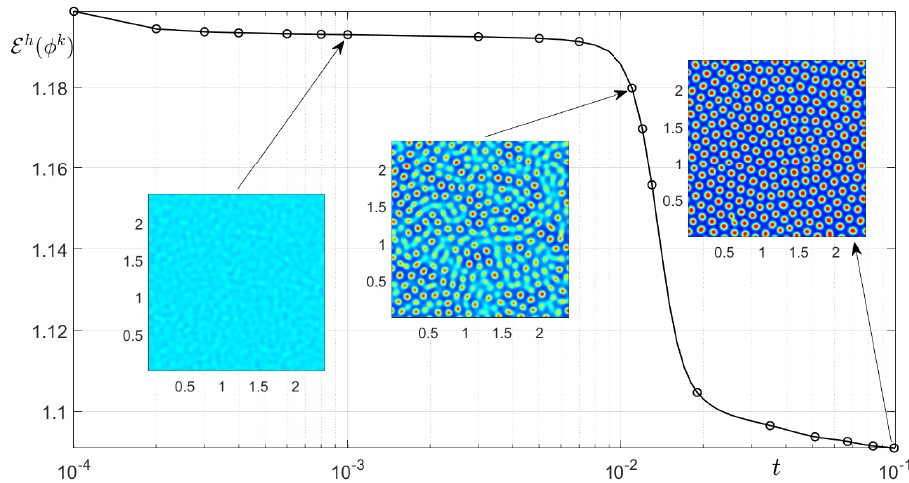
Figure 14. Energy dissipation over time to the nonlocal CH model (4) with the initial condition (43) . Note that t -axis is on